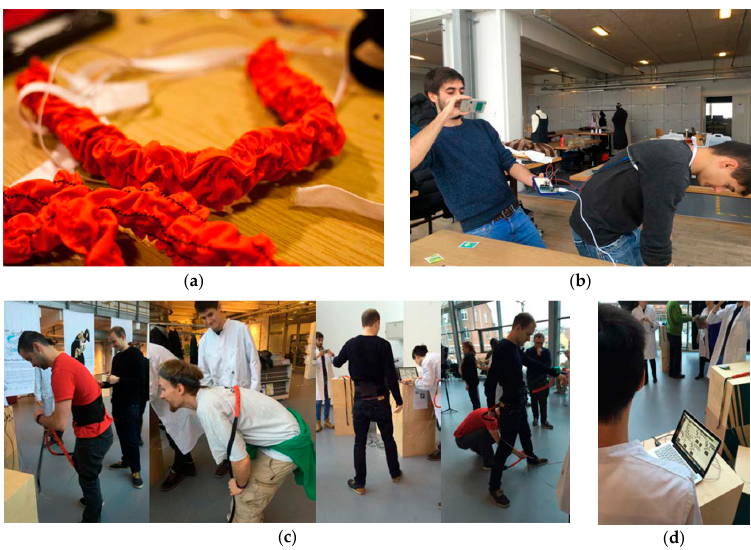
Figure 6. Loom 2 probe-set (3): Sensors + Sounds. ( a ) adjustable sensor straps; ( b ) studio testing; ( c ) participant play in the loom; ( d ) loom sound setup: computer running Max MSP with a live manipulated patch for sound experiments.